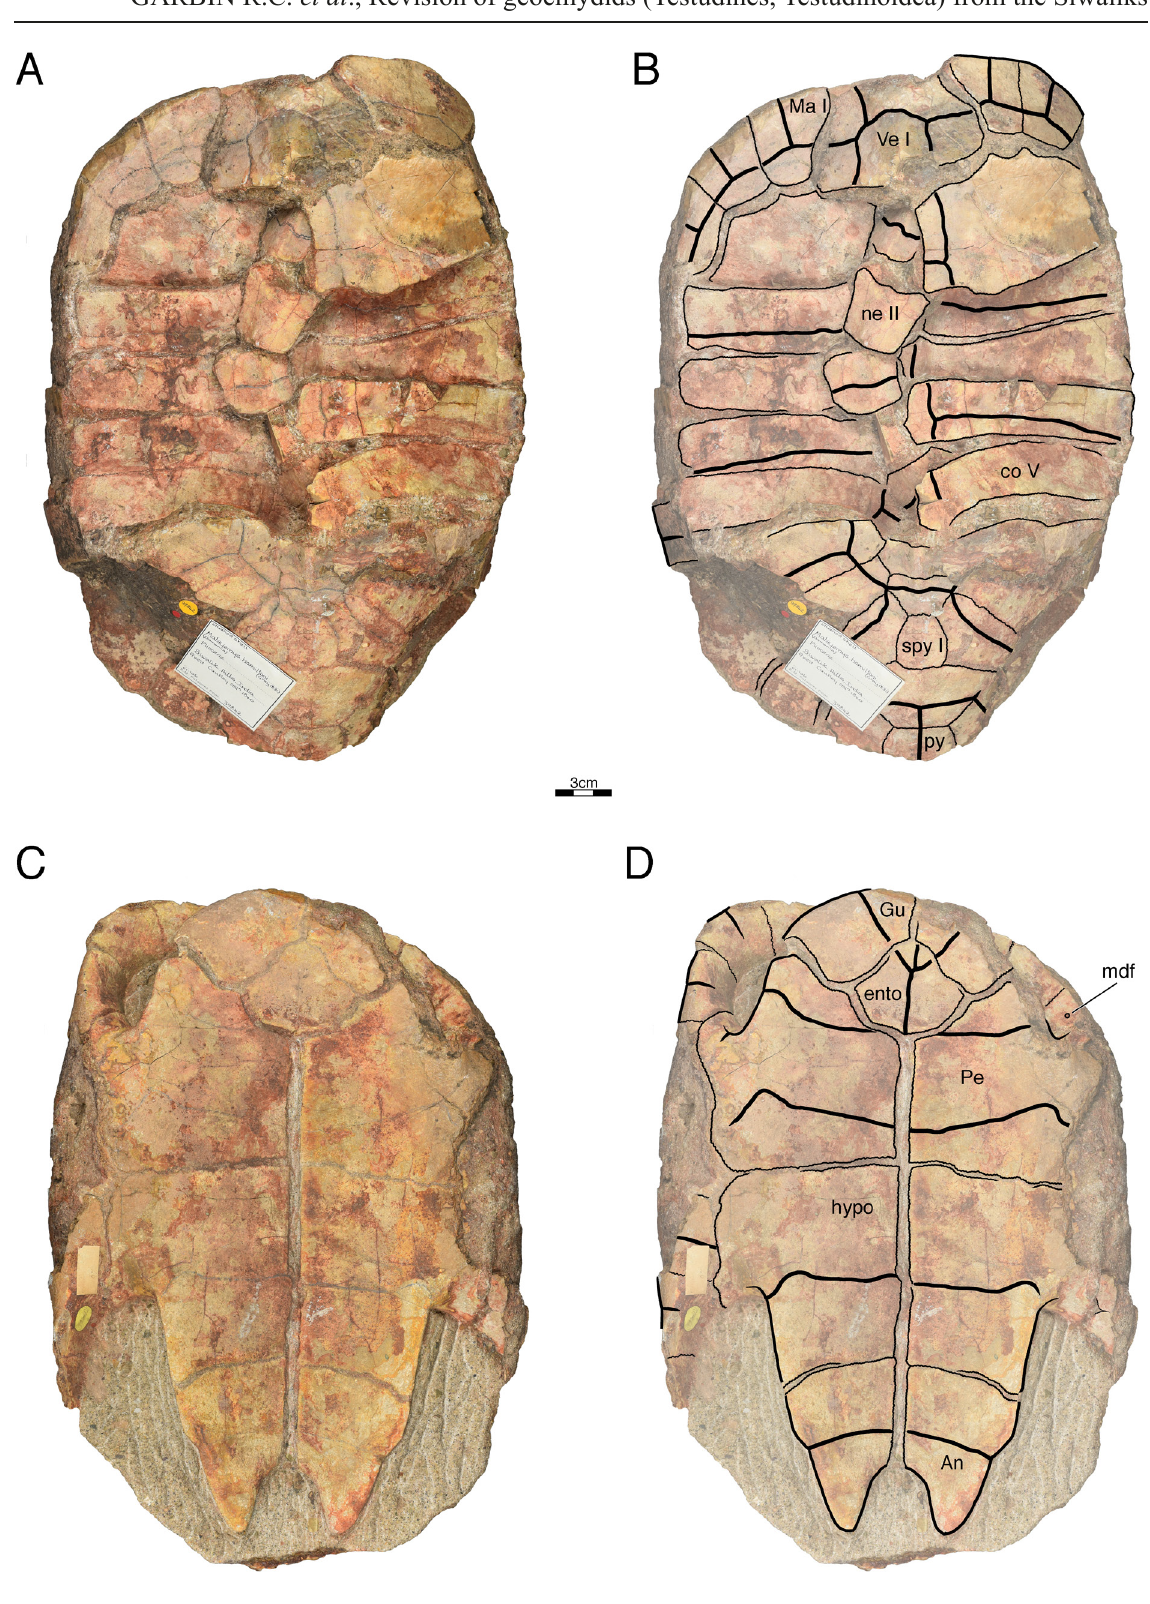
Fig. 24. BMNH 39842, referred to Damonia hamiltonii Gray, 1869 by Lydekker (1889b), here identified as synonym of Geoclemys hamiltonii (Gray, 1830). A . Photograph of carapace. B . Illustration